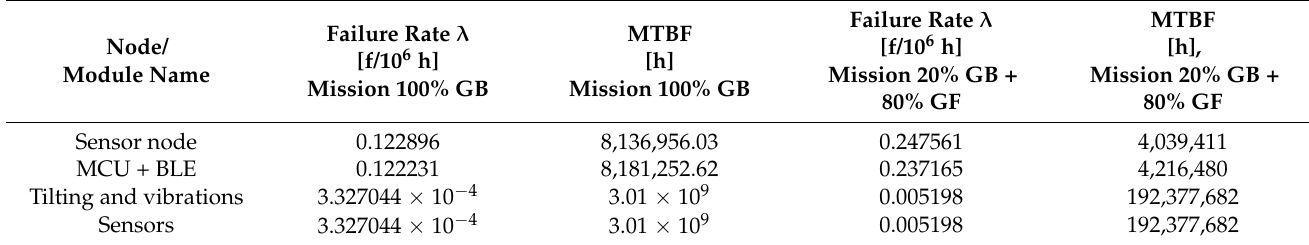
Table 2. Reliability analysis of the sensor node structure considering all the blocks working on continuous mode and considering 20% in GB and 80% in GF environments, in comparison with mission in 100% GB at 25 ◦